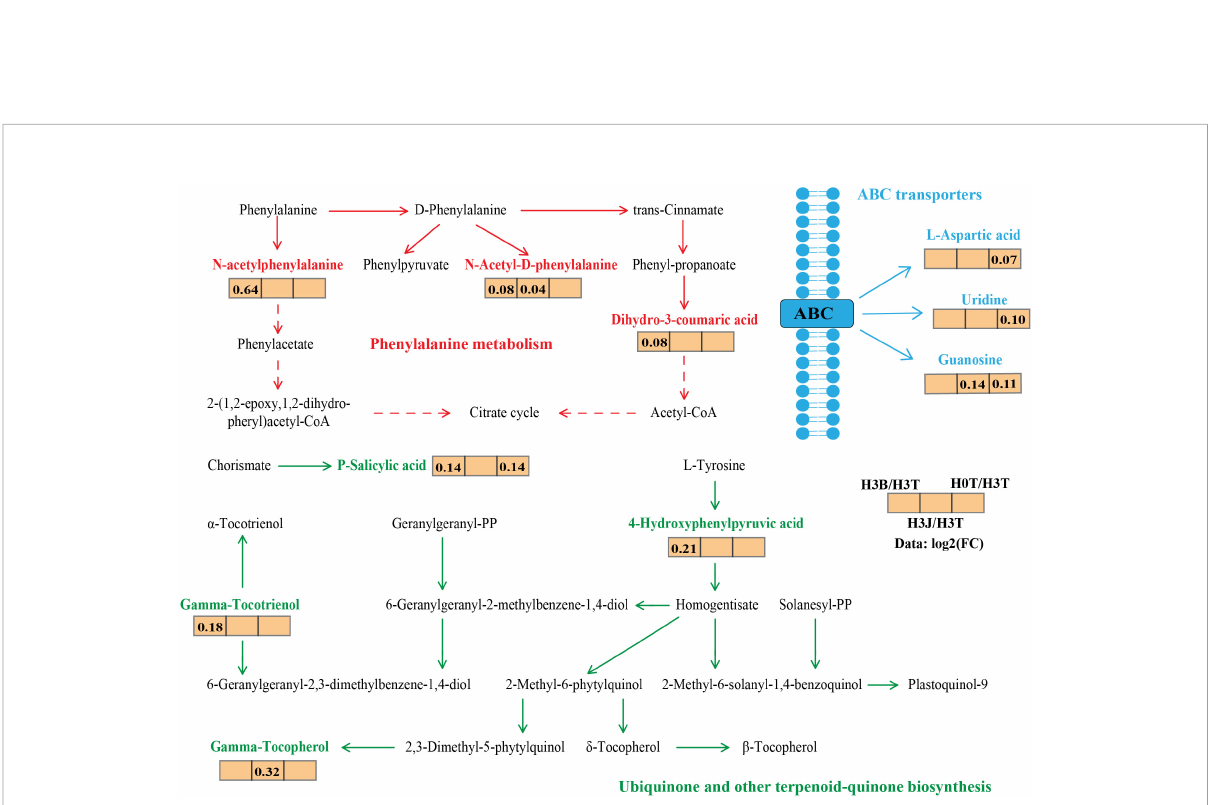
FIGURE 5 PLS-DA analysis of untargeted metabolomics data of cotton lateral root in the Cd, biochar, and biofertilizer treatments (left, cation) (right, anion). Ellipses represent the 95% con fi dence interval.